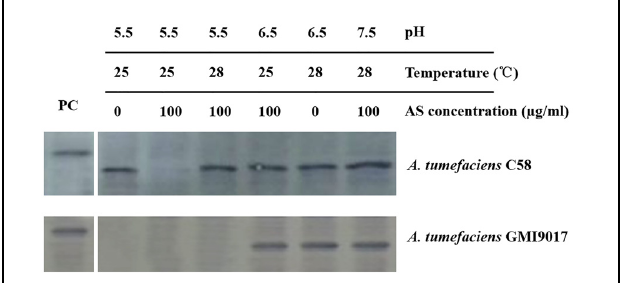
FIGURE 4 | Comparison of the expression of vbp2 in A. tumefaciens C58 and A. tumefaciens GMI9017 at different pHs, temperatures and AS concentrations. Both the A. tumefaciens strain C58 cells and GMI9017 cells were induced in parallel under the indicated pH, temperature or AS concentration. Crude extracts from the differentially induced Agrobacterium cells were separated using SDS-PAGE and then analyzed by Western blotting using antibody against VBP2. PC, positive control, crude extract from E. coli cells expressing vbp2 with His-tag.